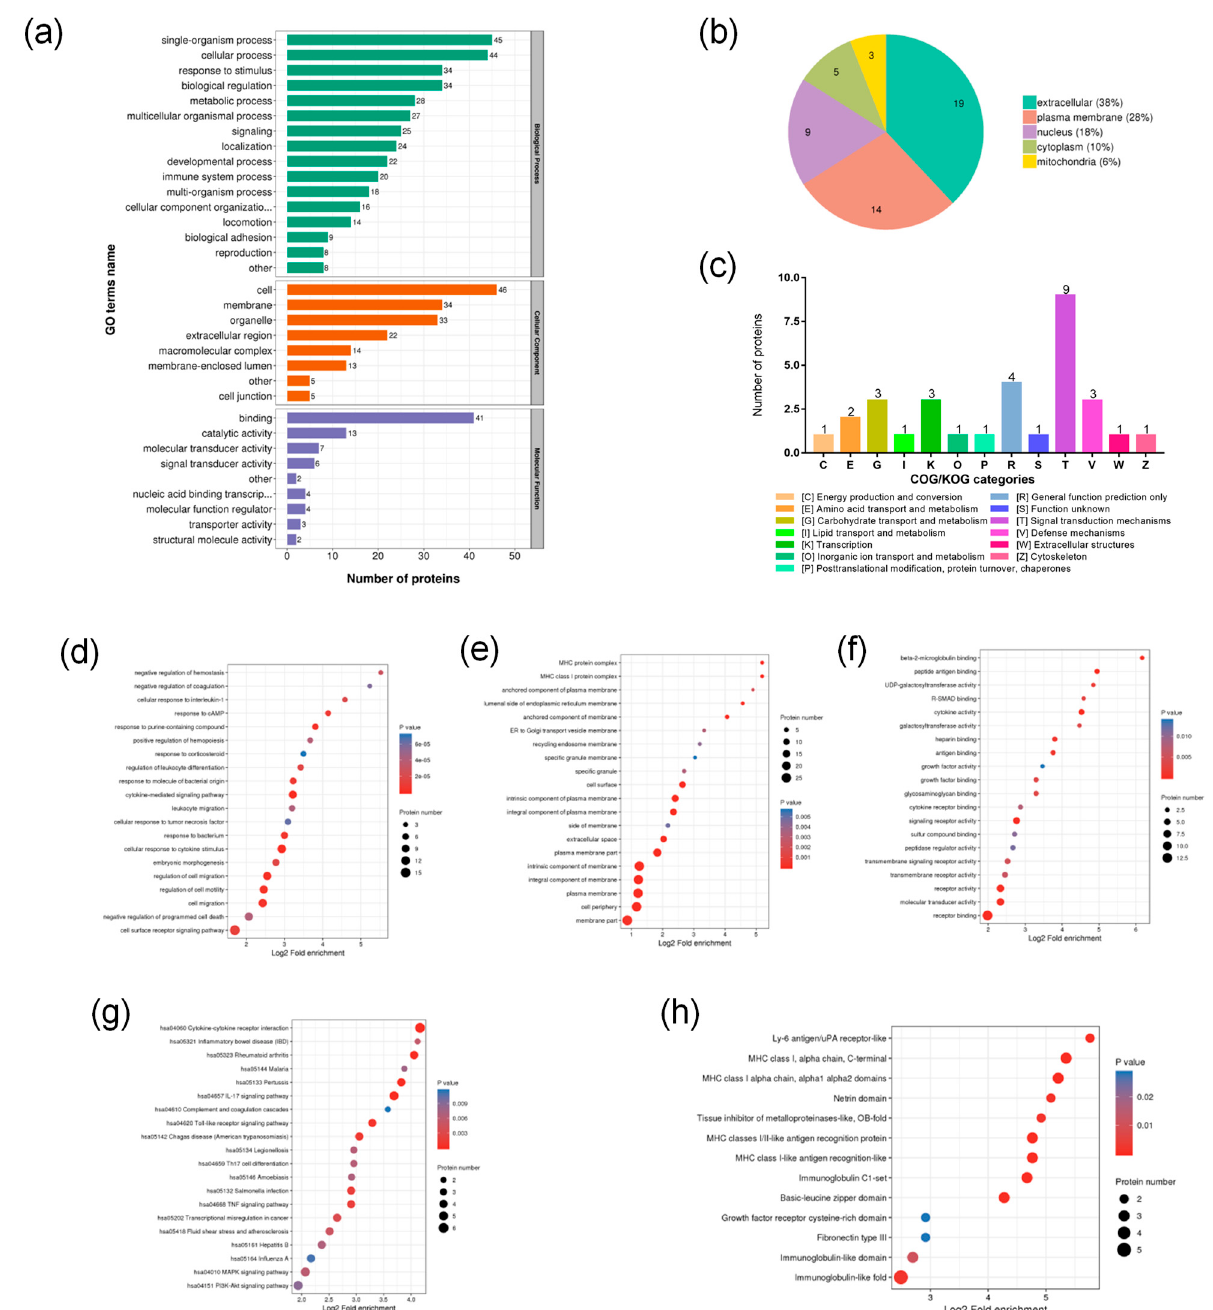
Figure 4. Functional classification and enrichment analysis of DEPs. ( a ) Statistical distribution of DEPs under each Gene Ontology (GO) category, including biological process (BP), cellular component (CC), and molecular function (MF); ( b ) Subcellular localization of DEPs; ( c ) Clusters of Orthologous Groups of proteins/euKaryotic Ortholog Groups (COG/KOG) functional classification of DEPs; ( d ) BP in GO enrichment; ( e ) CC in GO enrichment; ( f ) MF in GO enrichment; ( g ) Kyoto Encyclopedia of Genes and Genomes (KEGG) pathway enrichment analysis of DEPs; ( h ) Protein domain enrichment analysis of DEPs.